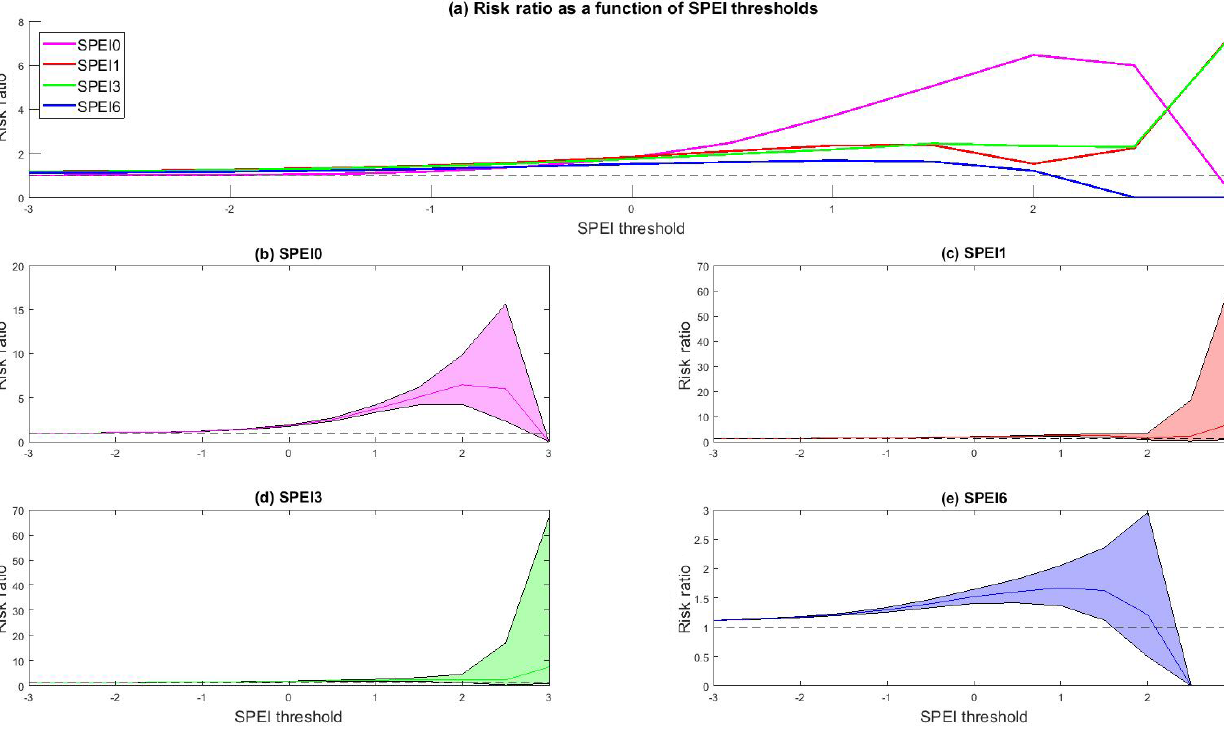
Figure 7. Risk ratio between F and NF as function of SPEI exceedance values (SPEI0, magenta; SPEI1, red; SPEI3, green; SPEI6, blue) (a) , and their confidence intervals (b–e) . The horizontal dashed line shows the risk ratio of